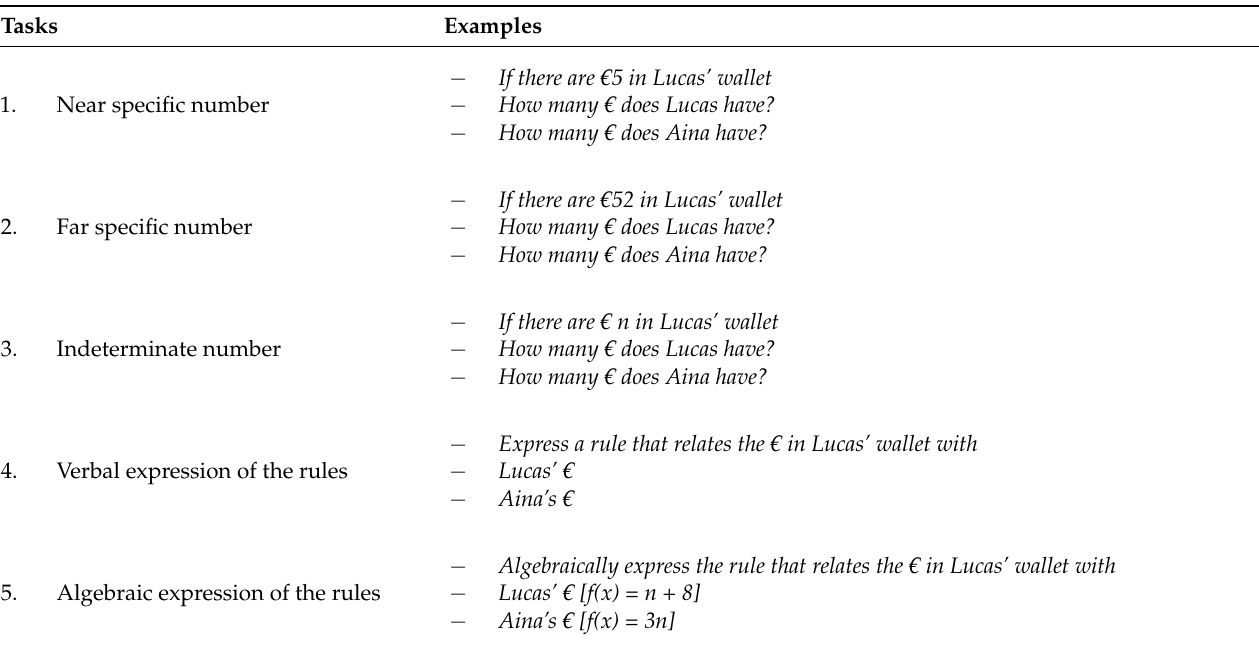
Table 7. Task sequence to promote algebraic thinking from case